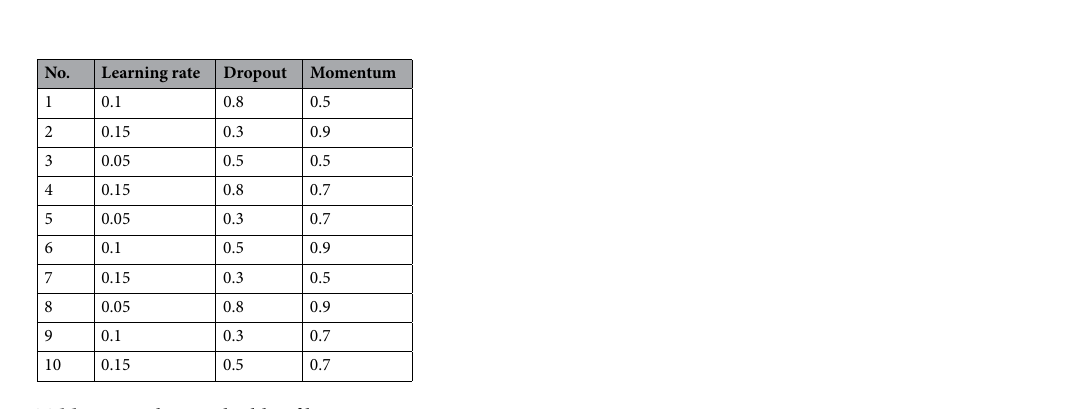
Table 2. Orthogonal table of